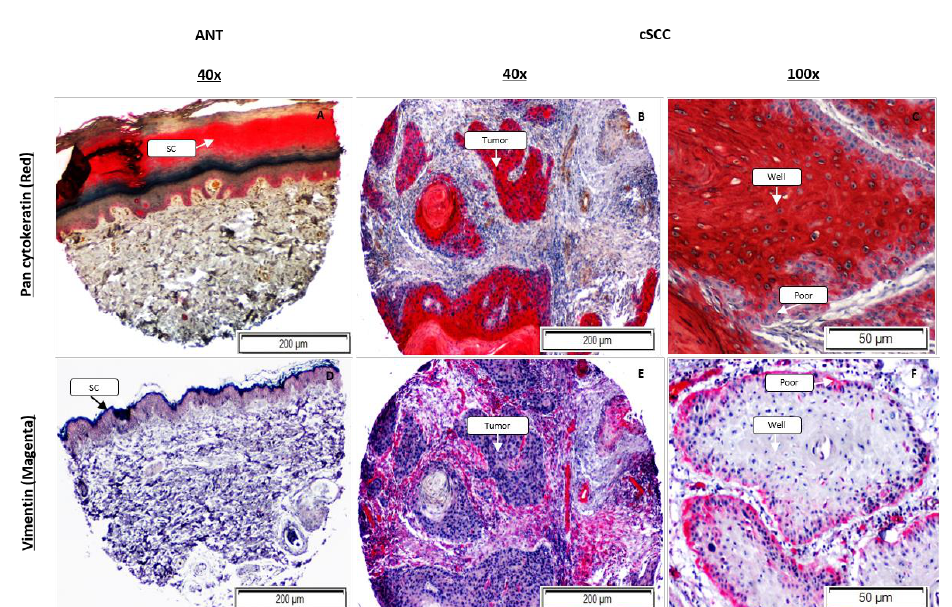
Figure 6. Immunohistochemistry of ANT and cSCC tissues for pan-cytokeratin (red; Panels A – C ) and vimentin (magenta; Panels D – F ). At 40× magnification, cSCC images delineate cSCC (tumor) tissue from the dermal tissue and ANT images are oriented with the stratum corneum (sc) layer at the top. Images at 100× magnification show that poorly differentiated cells (poor) along the edges of the tumor have a higher (2 – 3+) expression of the mesenchymal marker vimentin (Panel F ) com- pared to well-differentiated cells (well; 0 – 1+) in the center of the tumor mass. Poorly differentiated cells also show a visible reduction in the epithelial marker pan-cytokeratin (Panel C ). Tissue sections were stained with H&E for validation of epithelial tissue (images not shown).